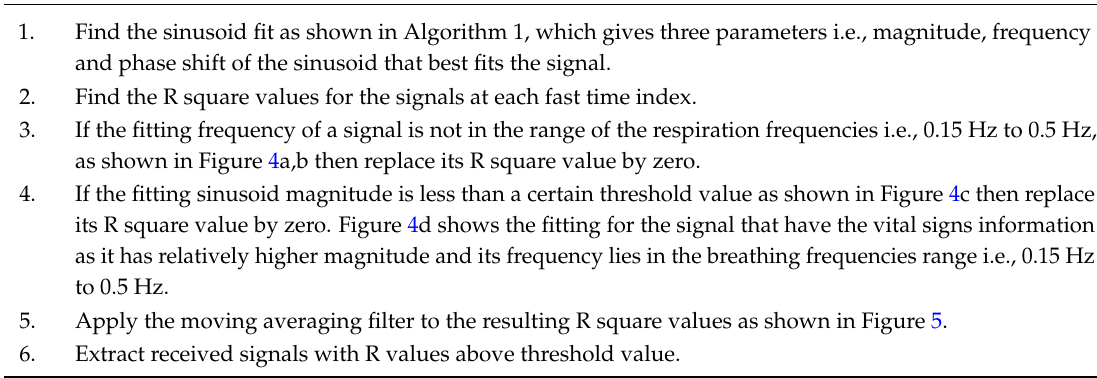
Algorithm 2: Selection of the fast time indexes that gives the best fit